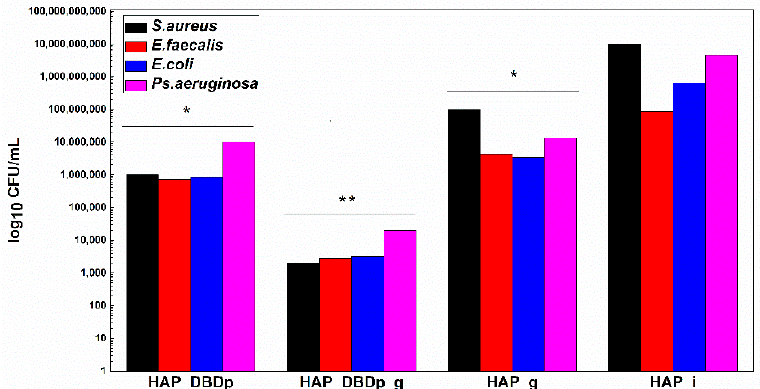
Figure 4. Graphic representation of microbial viability, expressed as log10 CFU (colony-forming